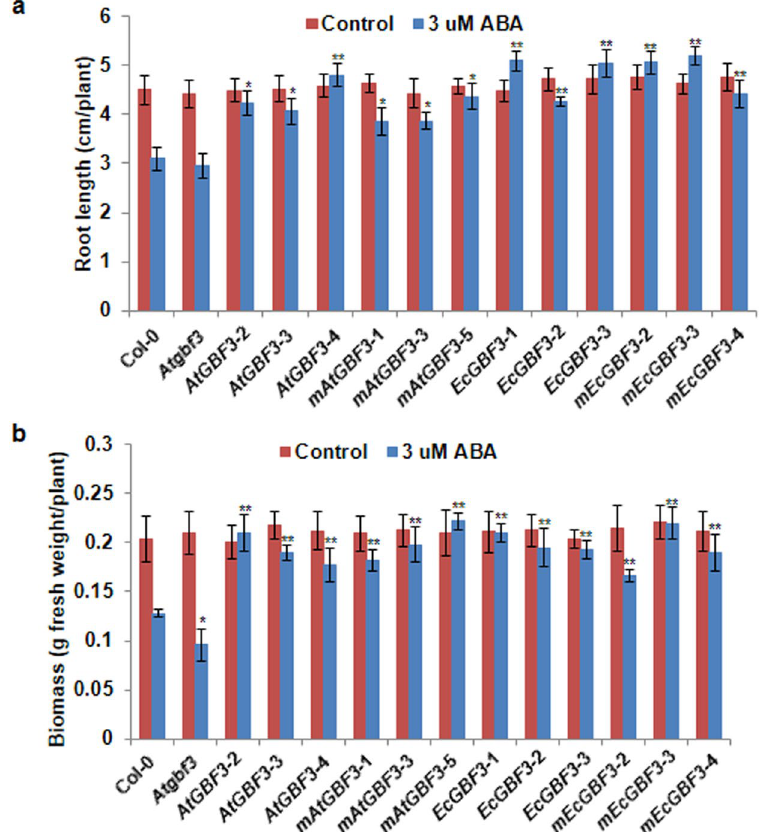
Figure 5. Insensitivity of AtGBF3 and EcGBF3 transgenic Arabidopsis plants to ABA. A week old hygromycin resistant T 3 transgenic seedlings along with Col-0 and Atgbf3 mutant seedlings were transferred on to medium (1/2 MS, 0.5% sucrose and 0.1% phytagel) containing 3 μ M ABA and growth performance was measured after 10 days. Root length ( a ) and biomass ( b ) were measured using plants carefully uprooted from the media and blotted on paper towel to remove any media. The values are means ± SE (n = 10). t test was used to show the statistical significance of the differences in the means of Atgbf3 mutant or transgenic plants from Col-0 plants. * and ** indicate significant difference from Col-0 plants at P ≤ 0.05 and P ≤ 0.01, respectively. Atgbf3 , AtGBF3 mutant; AtGBF3 -2, -3 and -4, transgenic lines overexpressing AtGBF3 ; mAtGBF3 -1, -3 and -5, transgenic lines overexpressing AtGBF3 in the Atgbf3 mutant background; EcGBF3 -1, 2 and 3, transgenic lines overexpressing EcGBF3 ; mEcGBF3 -2, 3 and 4, transgenic lines overexpressing EcGBF3 in the Atgbf3 mutant